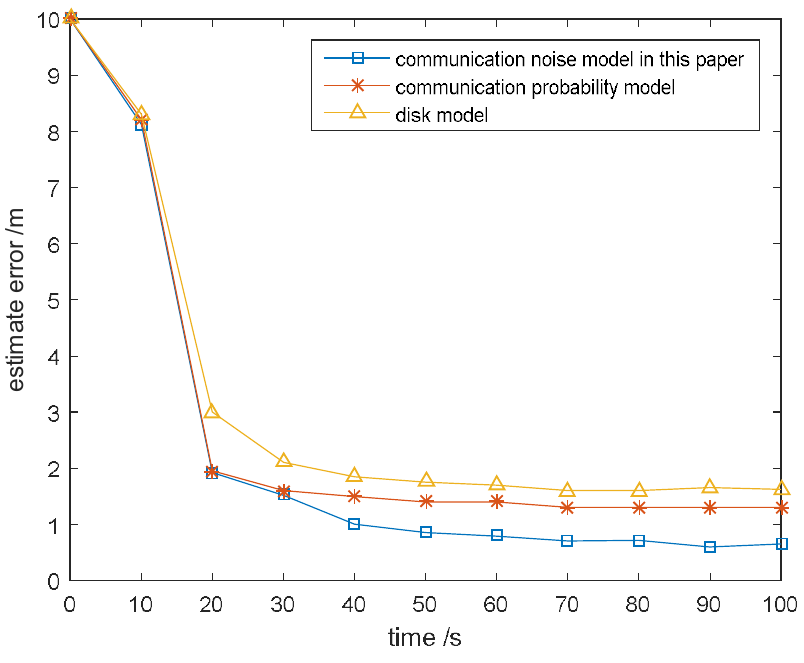
Figure 6. The average estimate error compared with other methods in the presence of distance-dependent path loss.